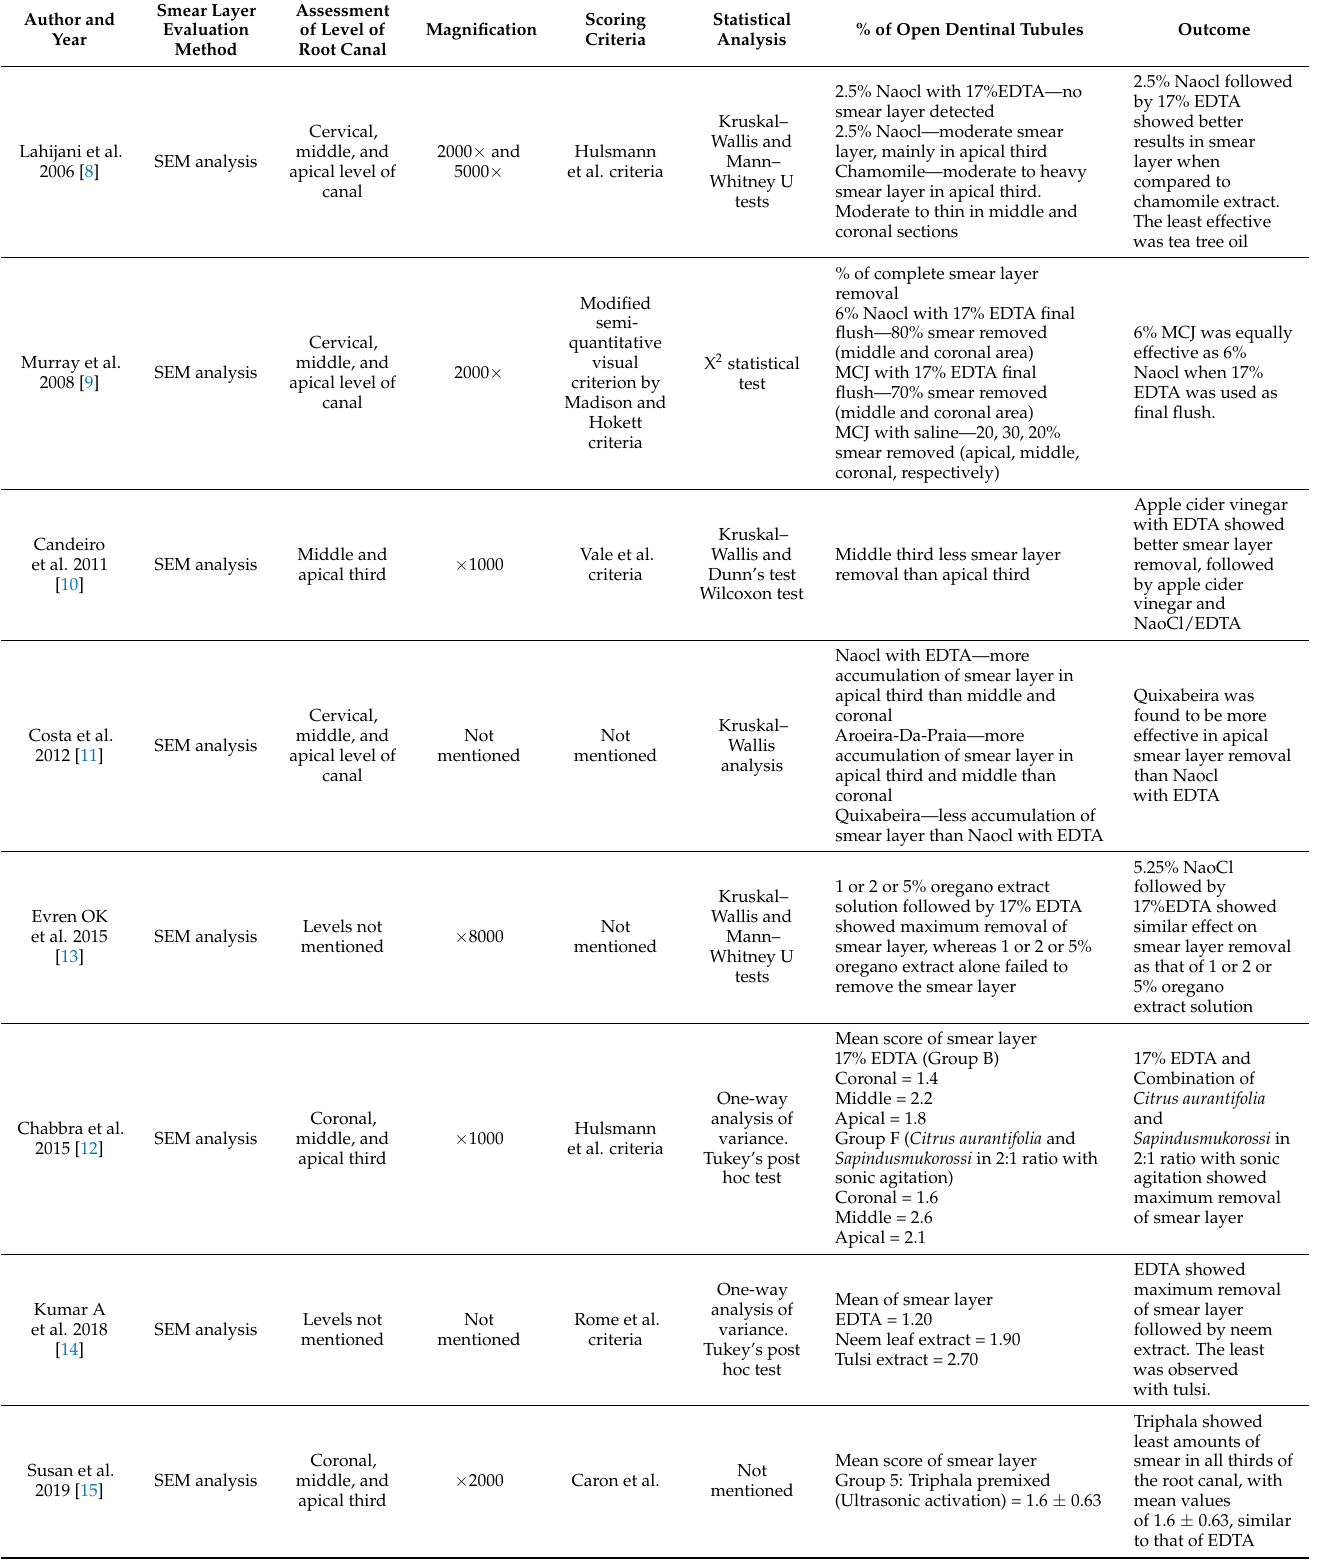
Table 5. Result assessment on smear